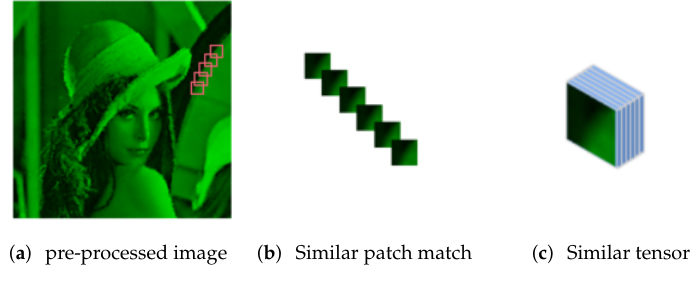
Figure 2. Process of patch